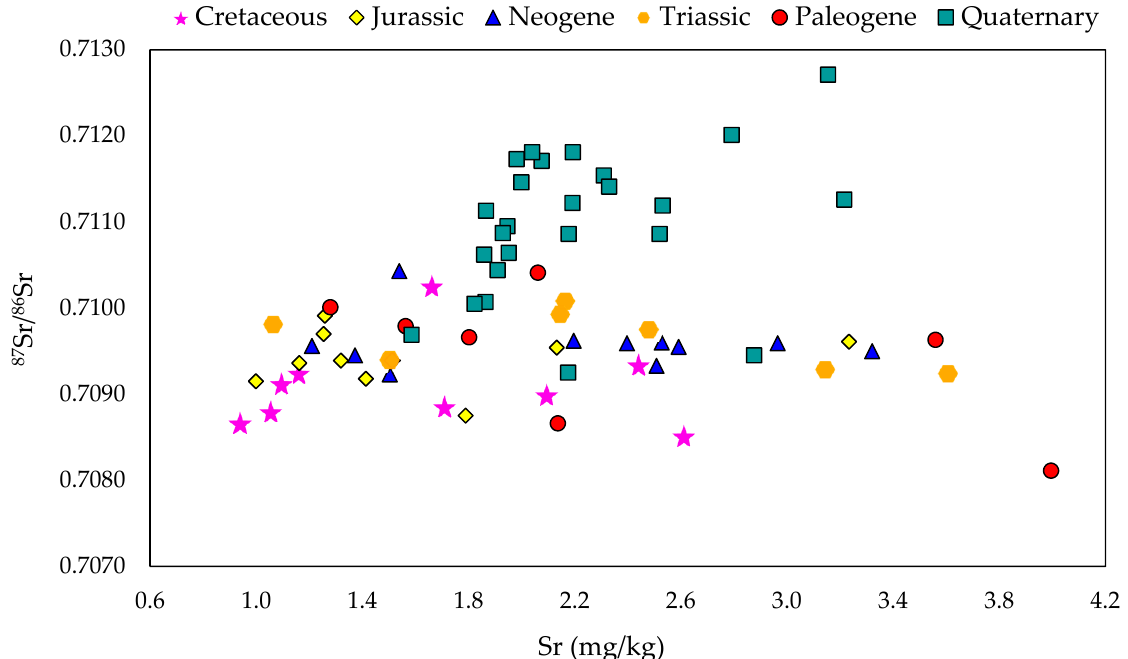
Figure 4. 87 Sr/ 86 Sr ratios versus Sr concentrations in milk from different geological regions.